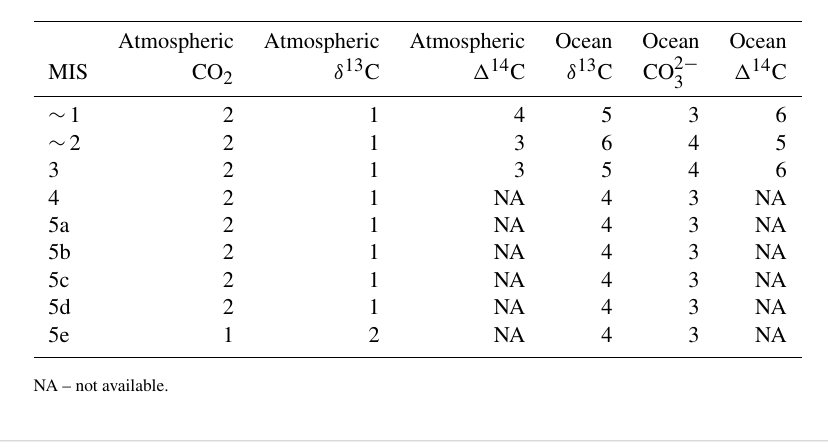
Table 3. Contribution of proxy data observations to the model–data experiment results for ocean parameter values in each MIS. Each proxy data observation from each model box is ranked from 1 to 6 in each MIS based on the relative standard deviation (RSD) of its data points. A ranking of 1 is given to the data observation with the smallest RSD in each MIS. A smaller RSD gives the data observation a higher weighting in the model–data optimization and therefore a greater contribution to the model results. (cid:49) 14 C proxy data do not exist for periods before MIS 3.